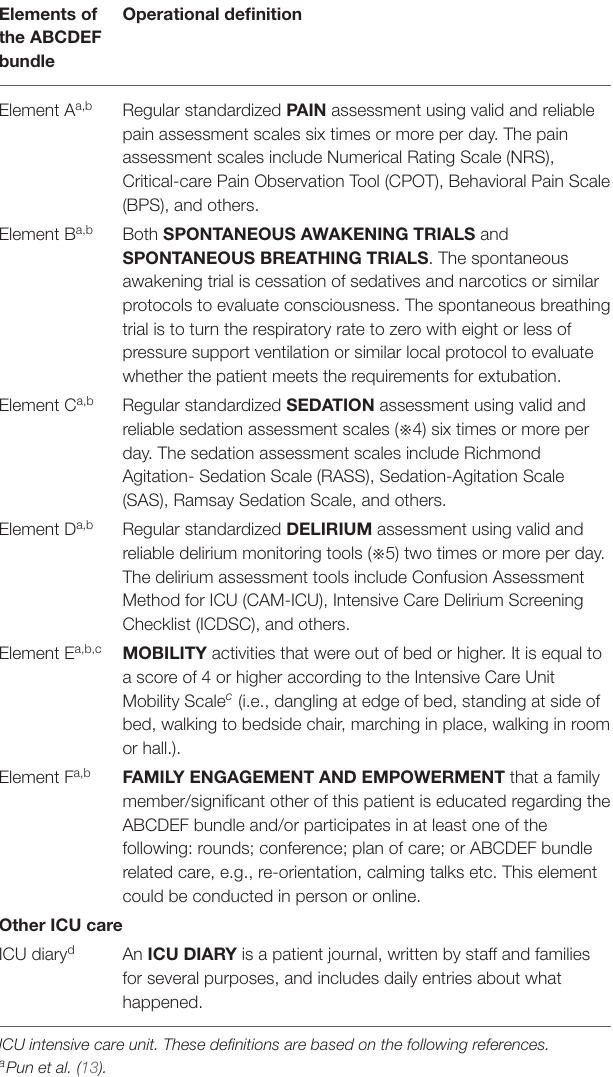
TABLE 1 | Operational definitions of evidence-based and supportive ICU